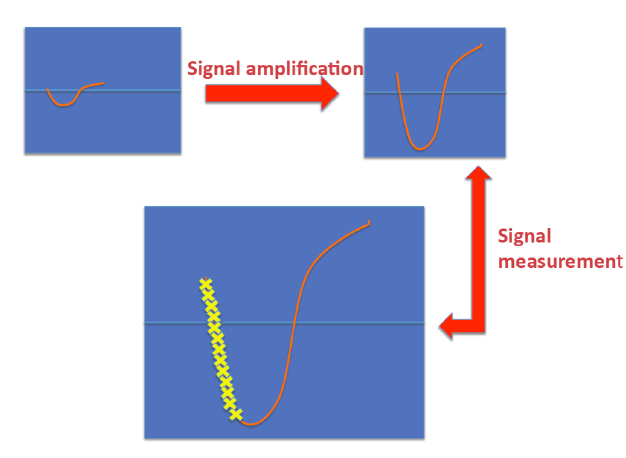
Fig. 1. Principle of signal analysis. A particle entering a fast Silicon detector induces a signal that is first amplified and then analyzed by performing a fast sampling of the signal (yellow crosses) that allow to measure the arrival time of the signal, its amplitude, shape and duration.